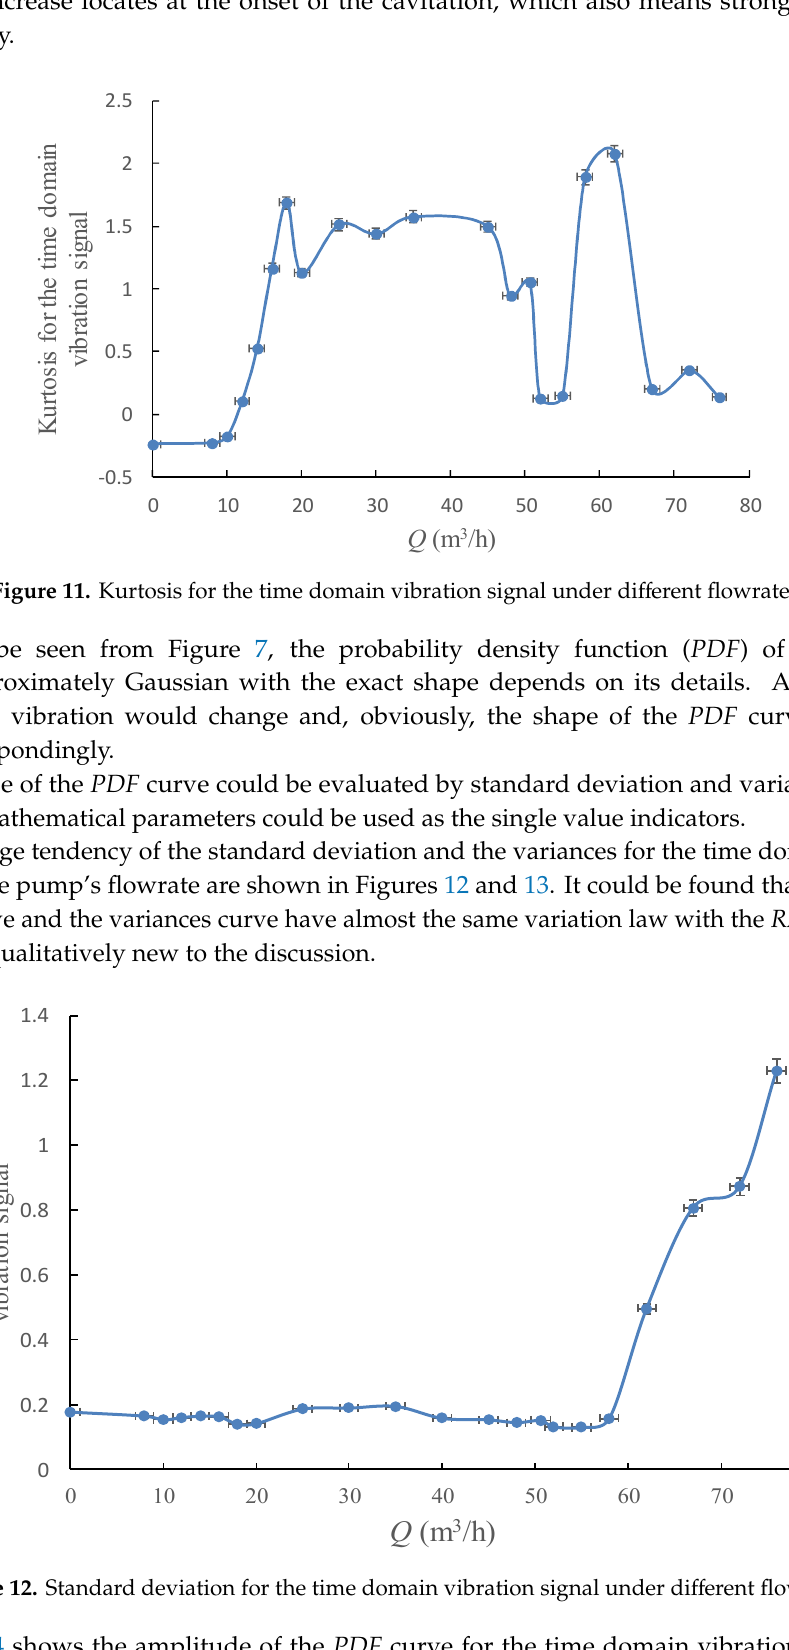
Figure 10. Crest factor for the time domain vibration signal under different flowrates.